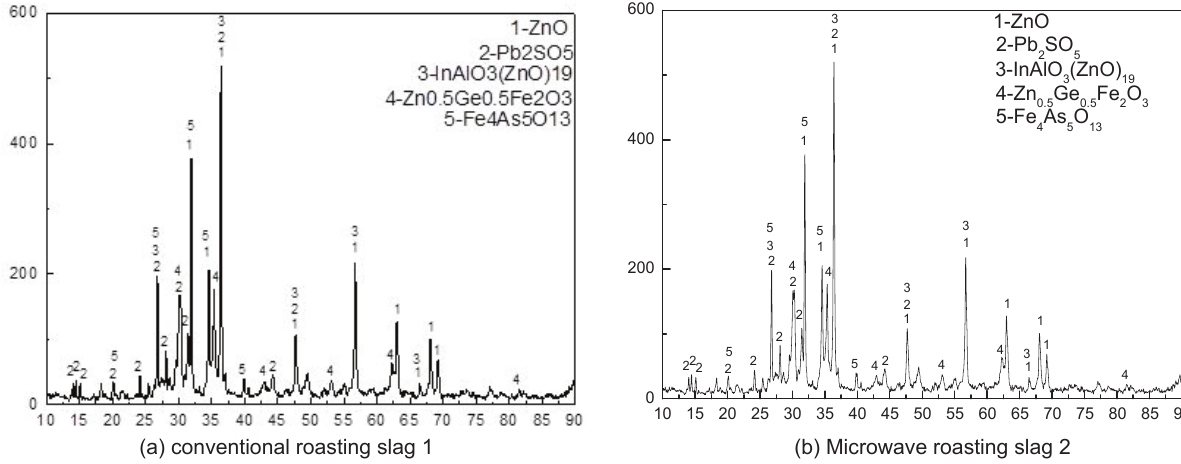
Figure 11: XRD spectrums of oxidizing roast slag using conventional and microwave roasting. also made soluble germanium to reform insoluble